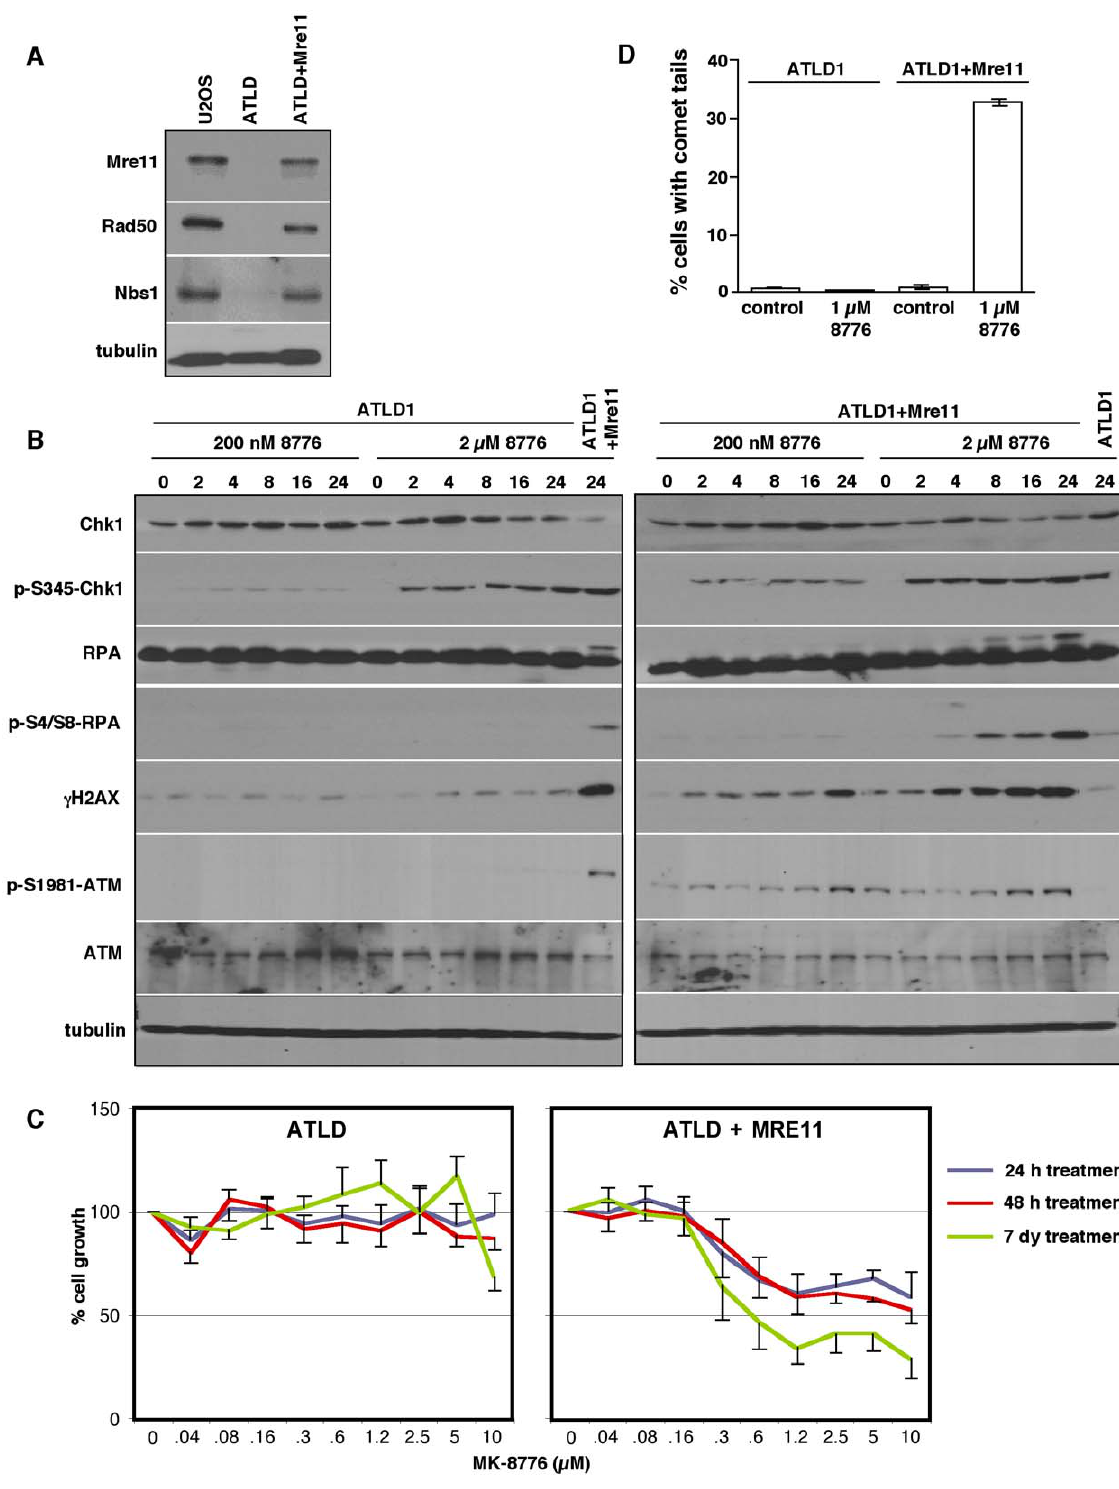
Figure 4. Mre11-deficient ATLD1 cells are resistant to MK-8776. A. Whole cell lysates from U2OS, ATLD1 and ATLD1 + Mre11 cells were analyzed by western blot for proteins of the MRN complex. B. ATLD1 and ATLD1 + Mre11 cells were incubated with 200 nM or 2 m M MK-8776 for 0– 24 h, harvested and analyzed by western blotting. The samples incubated for 24 h at 2 m M were also run beside the samples from the opposite cell line to compare signal intensities. C. Cells were incubated with MK-8776 for 24 h or 48 h then allowed to recover in drug-free media, or incubated continuously for 7 days with MK-8776. Total DNA content per well was then assessed as a measure of cell growth. Error bars (shown only in one direction for clarity) represent the standard error of 3 independent experiments. D. ATLD1 and ATLD1 + Mre11 cells were incubated for 24 h with and without 1 m M MK-8776. The neutral comet assay was performed and histograms represent cells with DSB. Error bars represent standard error of 2 independent experiments. doi:10.1371/journal.pone.0044021.g004 PLOS ONE | www.plosone.org